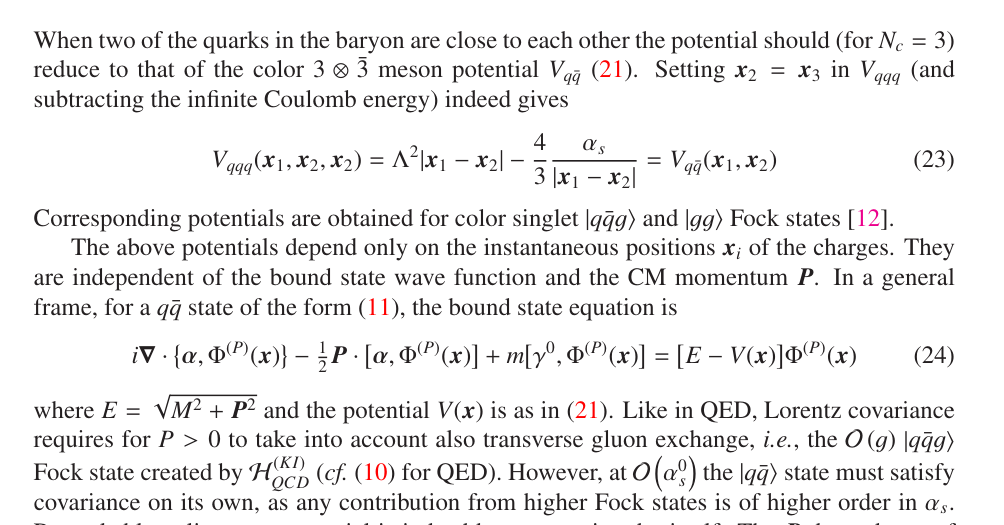
Figure 1. (a) The overlap A , B and C . The linear potential is nearly the same before and after the split, V ( δ 1 + δ 2 ) (b) Hadron loop correction through the creation and annihilation of a q ¯ q